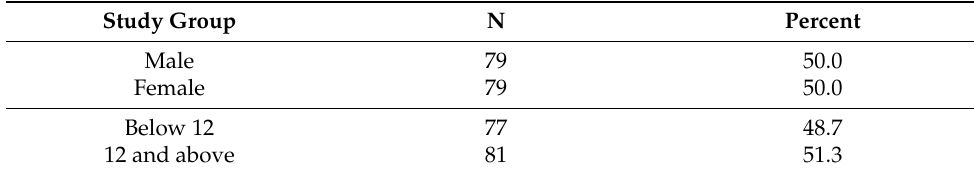
Table 1. Composition of the study group. Study Group N